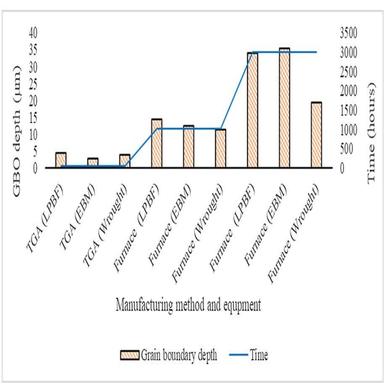
GBO thickness variation in LPBF, EBM and wrought Inconel 718 alloy .